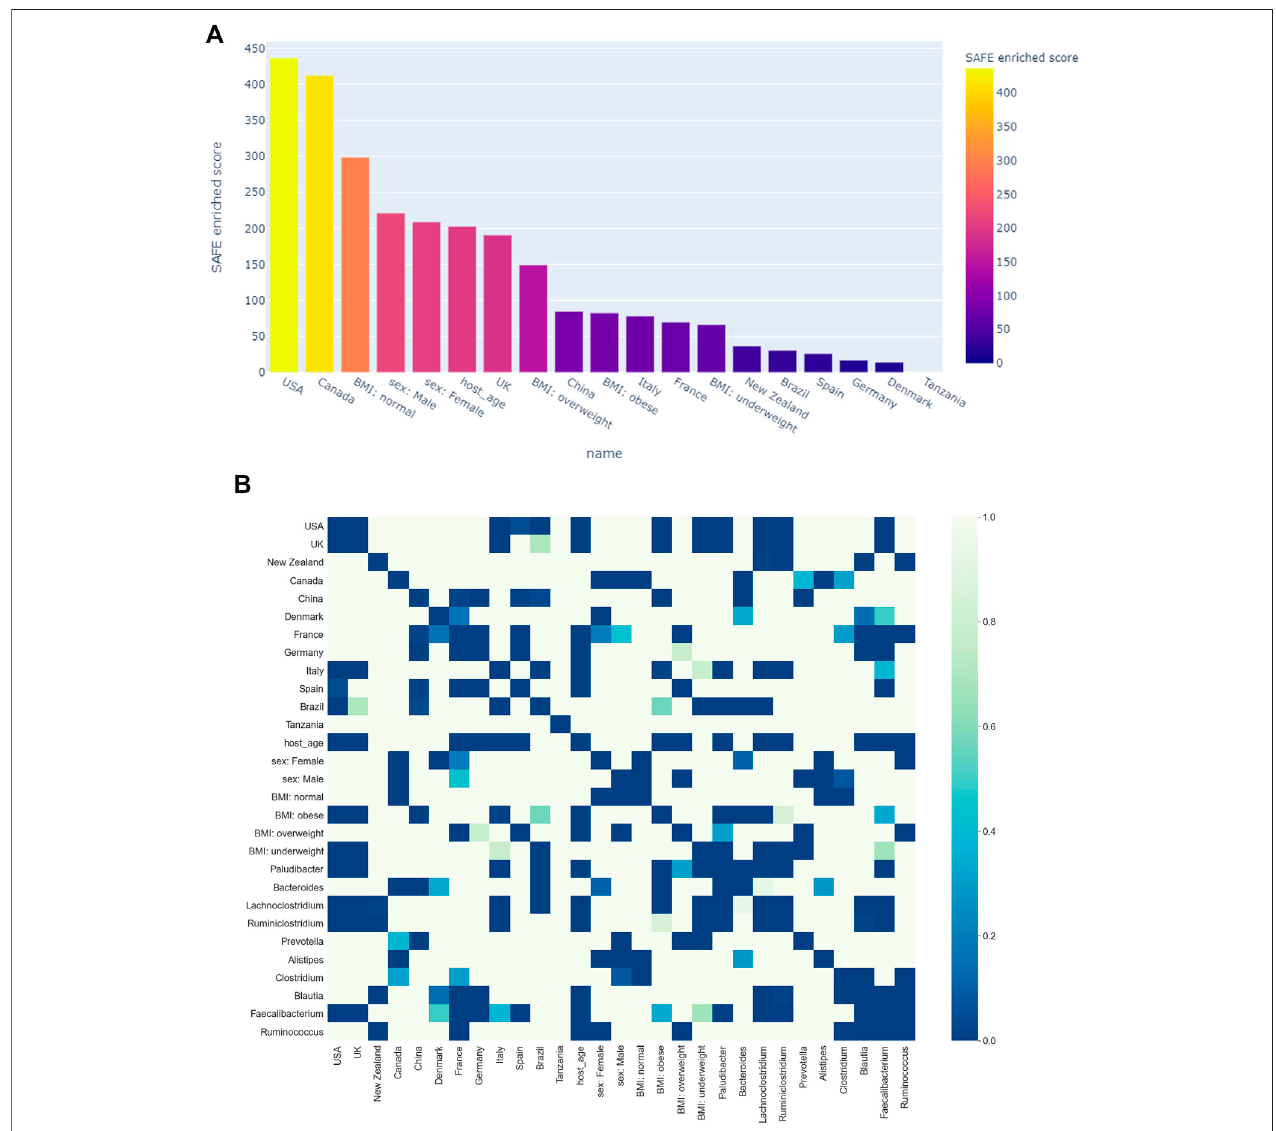
FIGURE 6 | (A) Ranking of host metadata by their SAFE enriched score. (B) Co-enrichment signi fi cance values of host metadata and the most enriched taxa, presented as a heatmap. The signi fi cance threshold was set at the 0.5 th percentile threshold of all values.